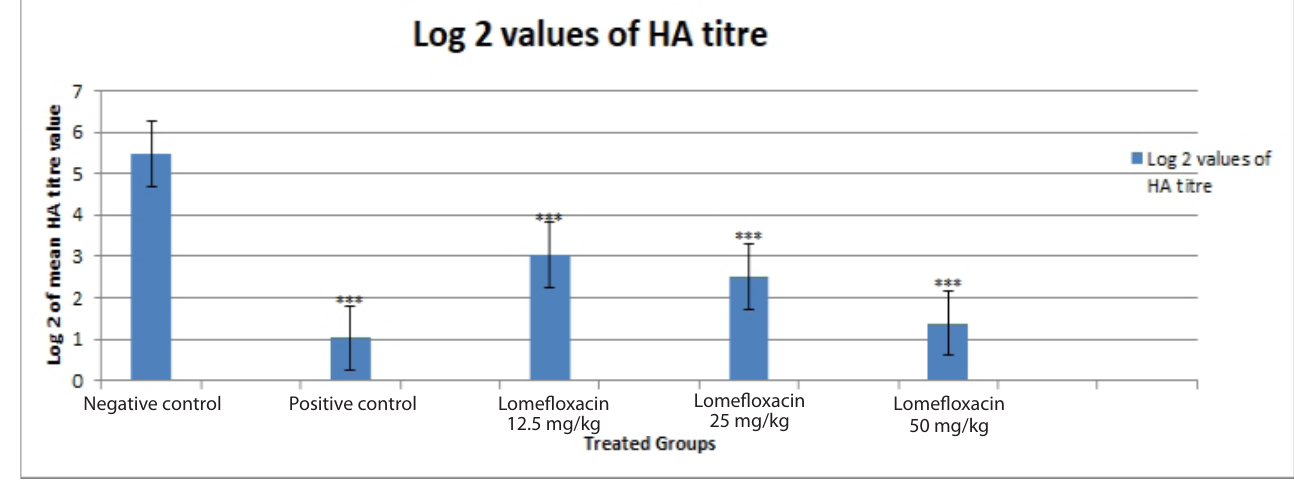
FIGURE 4 - Log 2 of mean HA titre